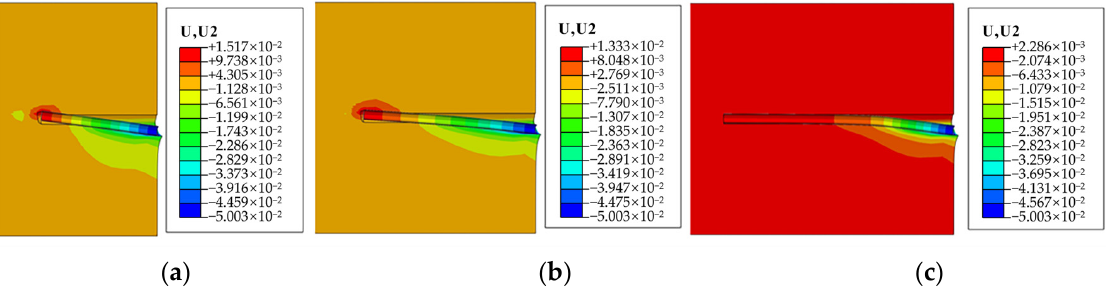
Figure 14. Deformation of steel pipe with different lengths in soil (m). ( a ) Steel pipe of 50cm in length. ( b ) Steel pipe of 75 cm in length. ( c ) Steel pipe of 100 cm in length.